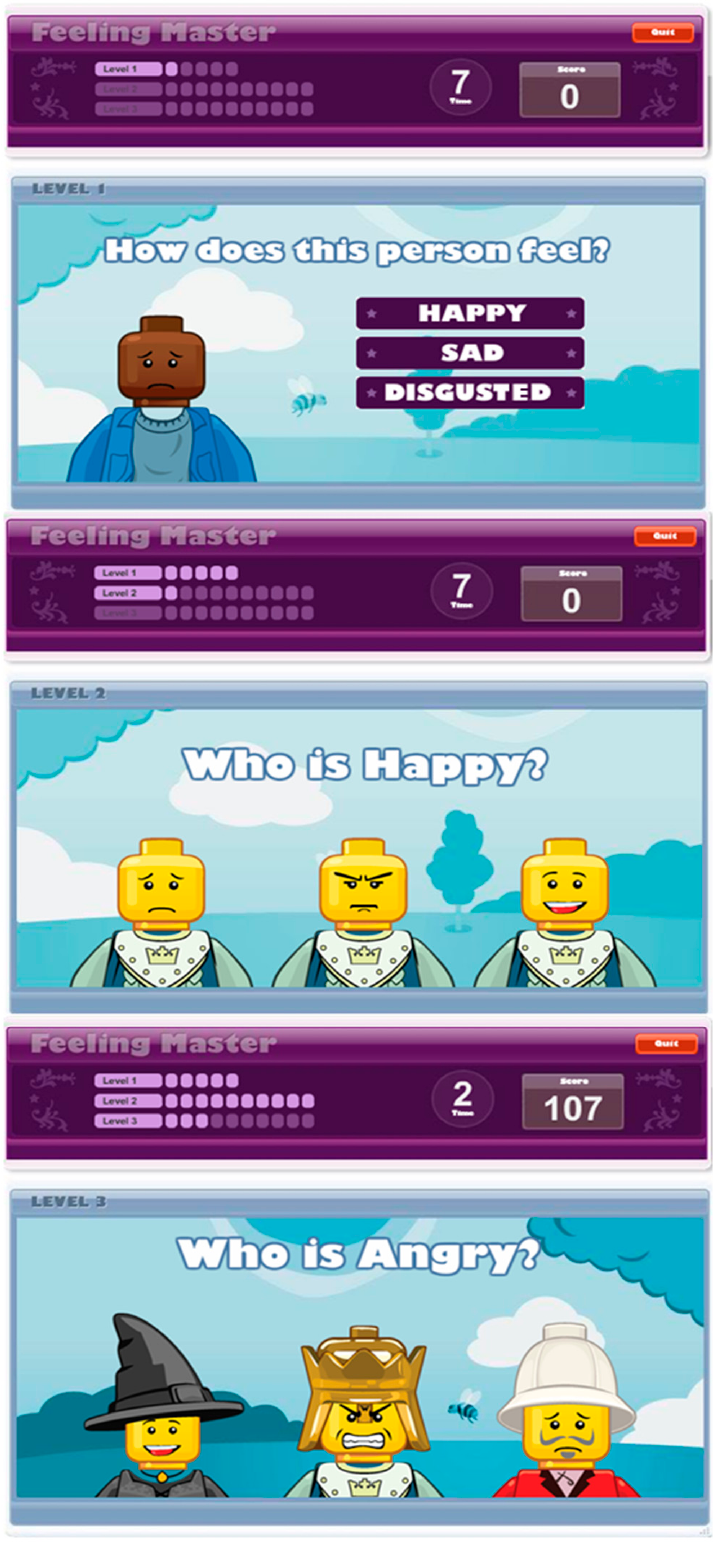
Figure 3. Interactive ‘Feeling Master’ tool.